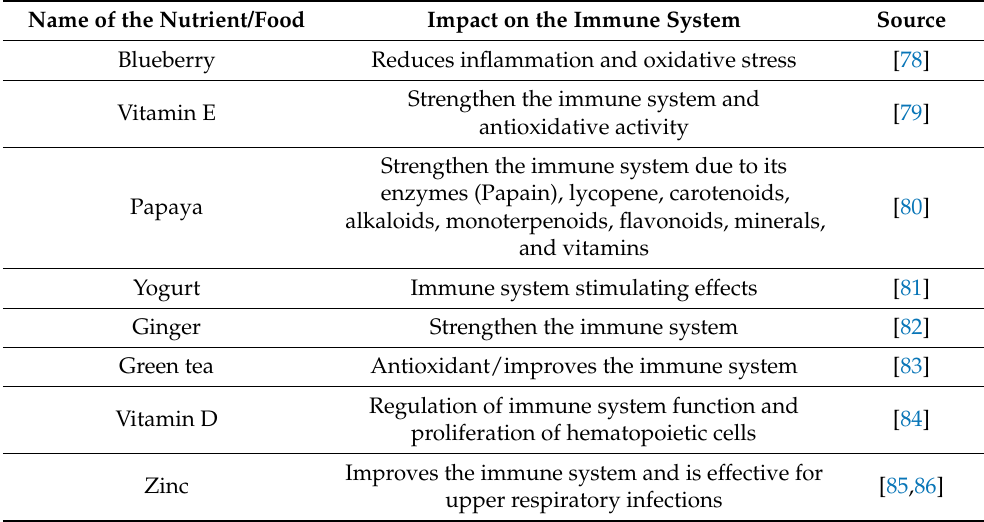
Table 3. The importance of nutrition for the immune function. Name of the Nutrient/Food Impact on the Immune System